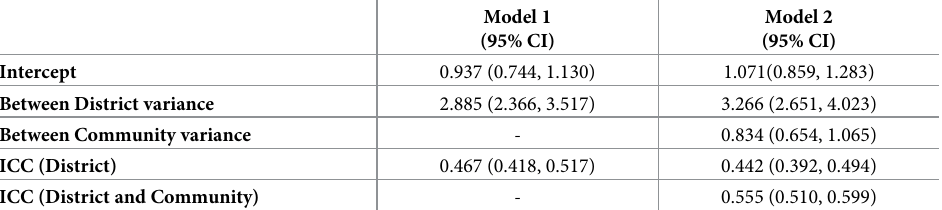
Table 3. Null models: With District Effects (Model 1) and District and Community Effects (Model